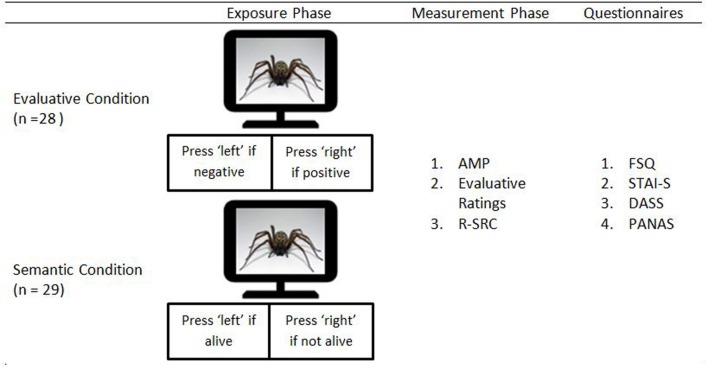
Schematic overview of the experimental procedure.